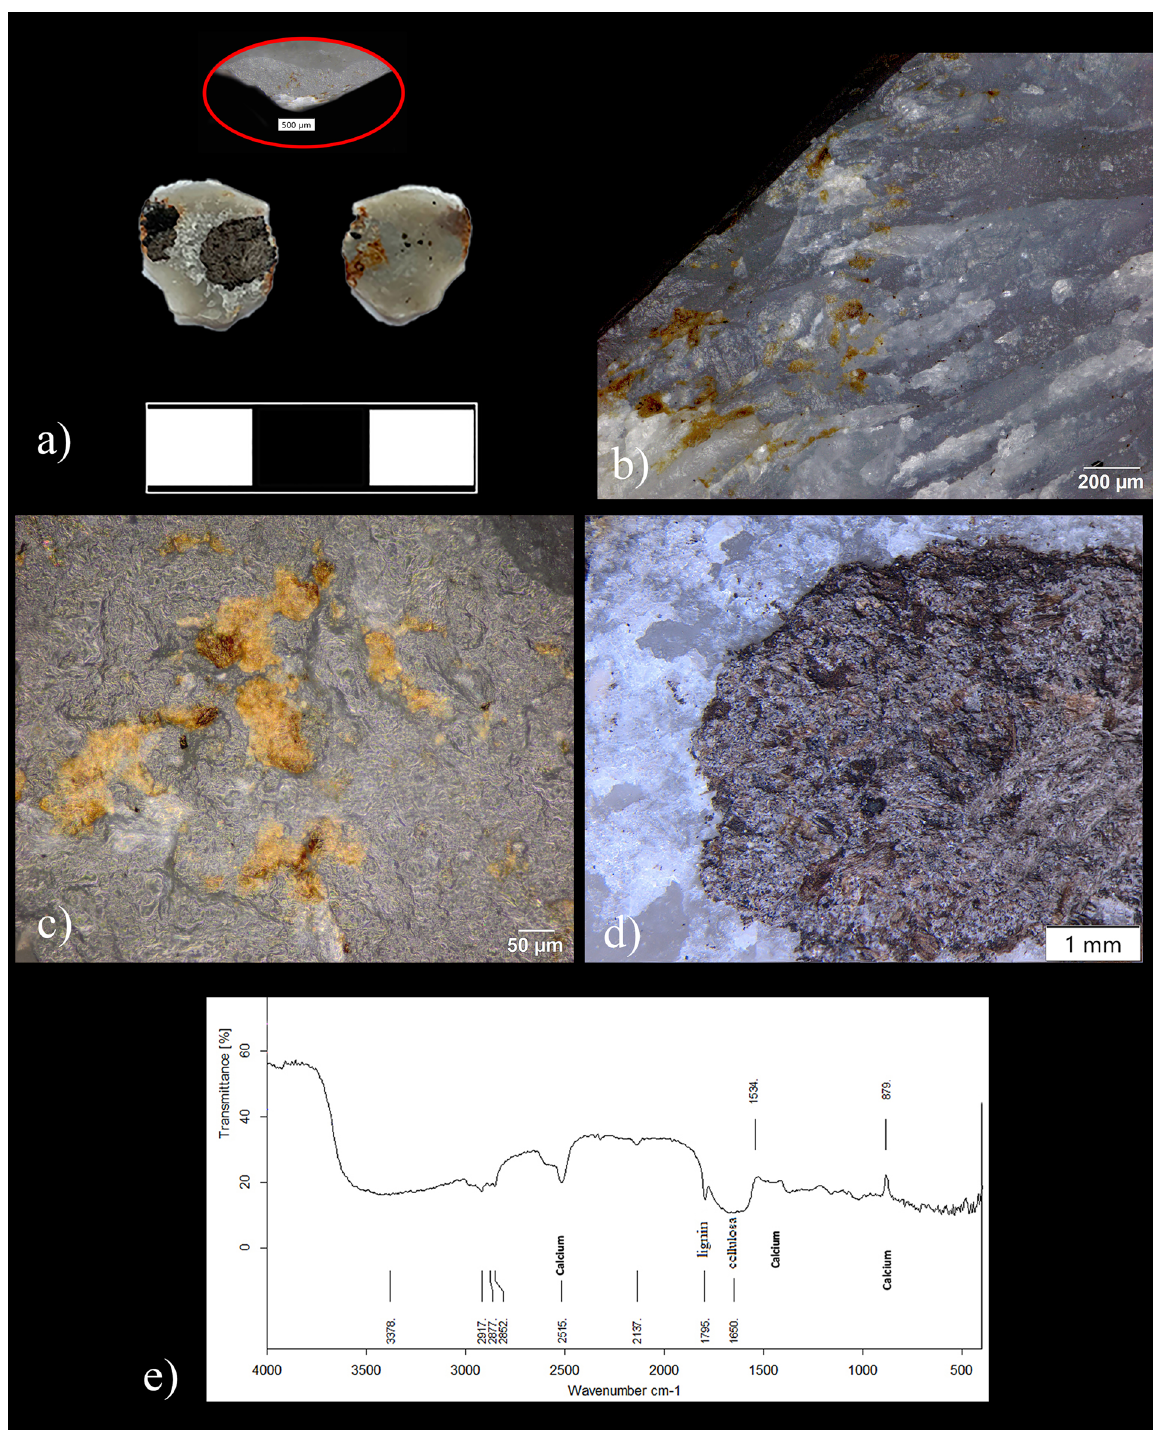
Figure 6. Archeological resharpening flake from the elephant area at the site Schöningen 13 II-3. ( a ) microflake ID 30255; ( b ) microresidues stuck on the dorsal proximal retouch scars and interpreted as tiny woody remains (Magnification: 200x); ( c ) microresidues of wood adhering on the butt (Magnification: 500x, dark field); ( d,e ) soil particles adhering to the dorsal surface and related FTIR spectroscopic absorptions showing a high concentration of calcium carbonate (Magnification in ( d ):